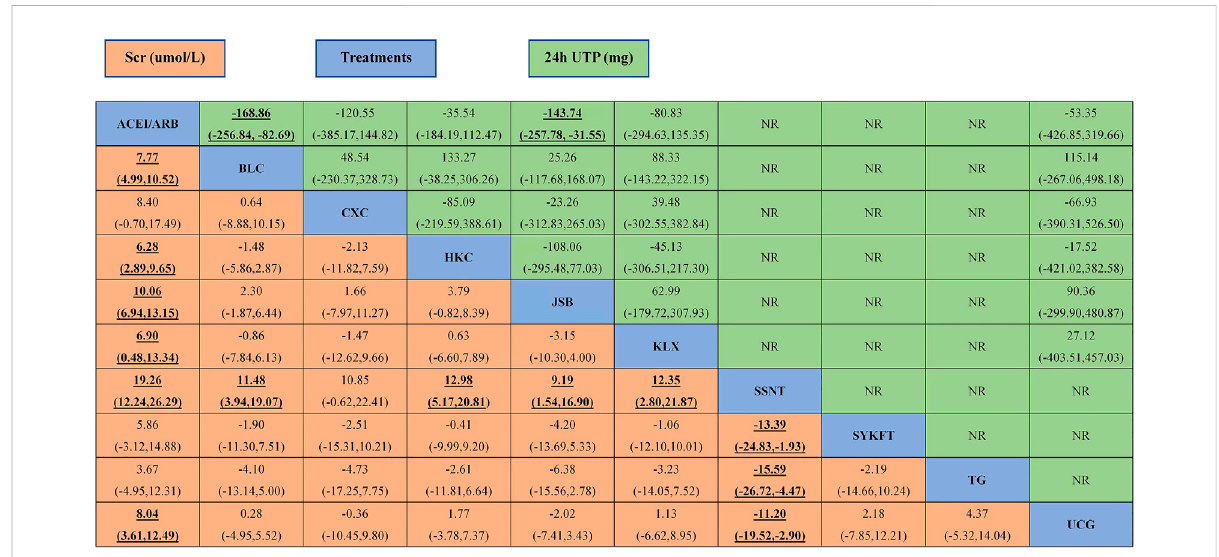
FIGURE 5 The league table of all comparisons of Scr and 24 h UTP. Data are MDs (95% CI) for 24 h UTP (upper-right quadrant) and MDs (95% CI) for Scr (lower-left quadrant) in the column-de fi ning treatment compared with the row-de fi ning treatment. Signi fi cant results are in bold and underscored. BLC, Bailing capsule; JSB, Jinshuibao capsule; HKC, Huangkui capsule; UCG, uremic clearance granule; TG, tripterygium glycosides; CXC, Compound Xueshuantong capsule; SYKFT, Shenyan Kangfu tablet; KLX, Keluoxin capsule; SSNT, Shenshuaining tablet; ACEI,